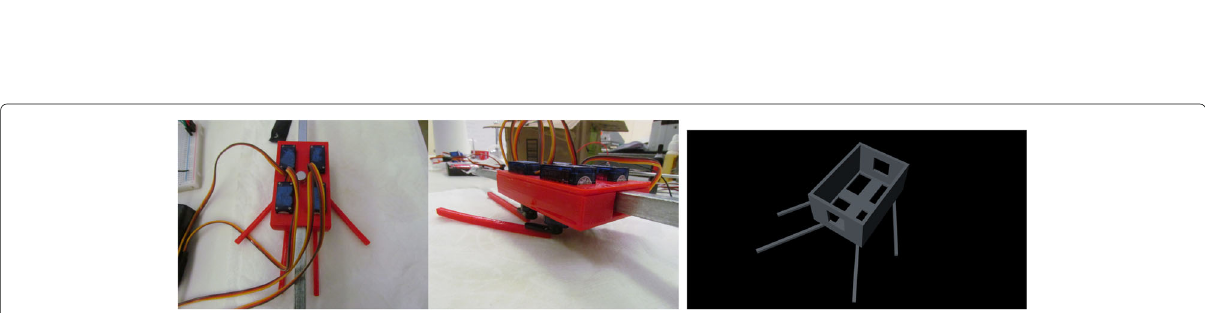
Fig. 24 Top and side view of the robotic copepod. We can distinguish the four slender legs each attached to their own micro-servo (in blue). The robotics copepod was constructed with a 3D printer Flashforge creator pro whose 3D design can be seen on the right image